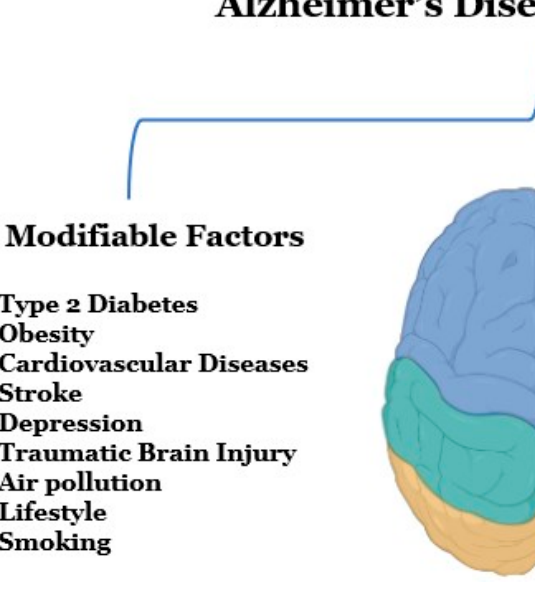
Figure 1. Potential risk factors for Alzheimer’s disease. There are two types of risk factors for Alzheimer’s disease that are modifiable and non-modifiable factors. Modifiable risk factors mainly include diseases, brain injuries, unhealthy lifestyles, and environmental factors, and non-modifiable factors include age, gender, family history, and genetics.